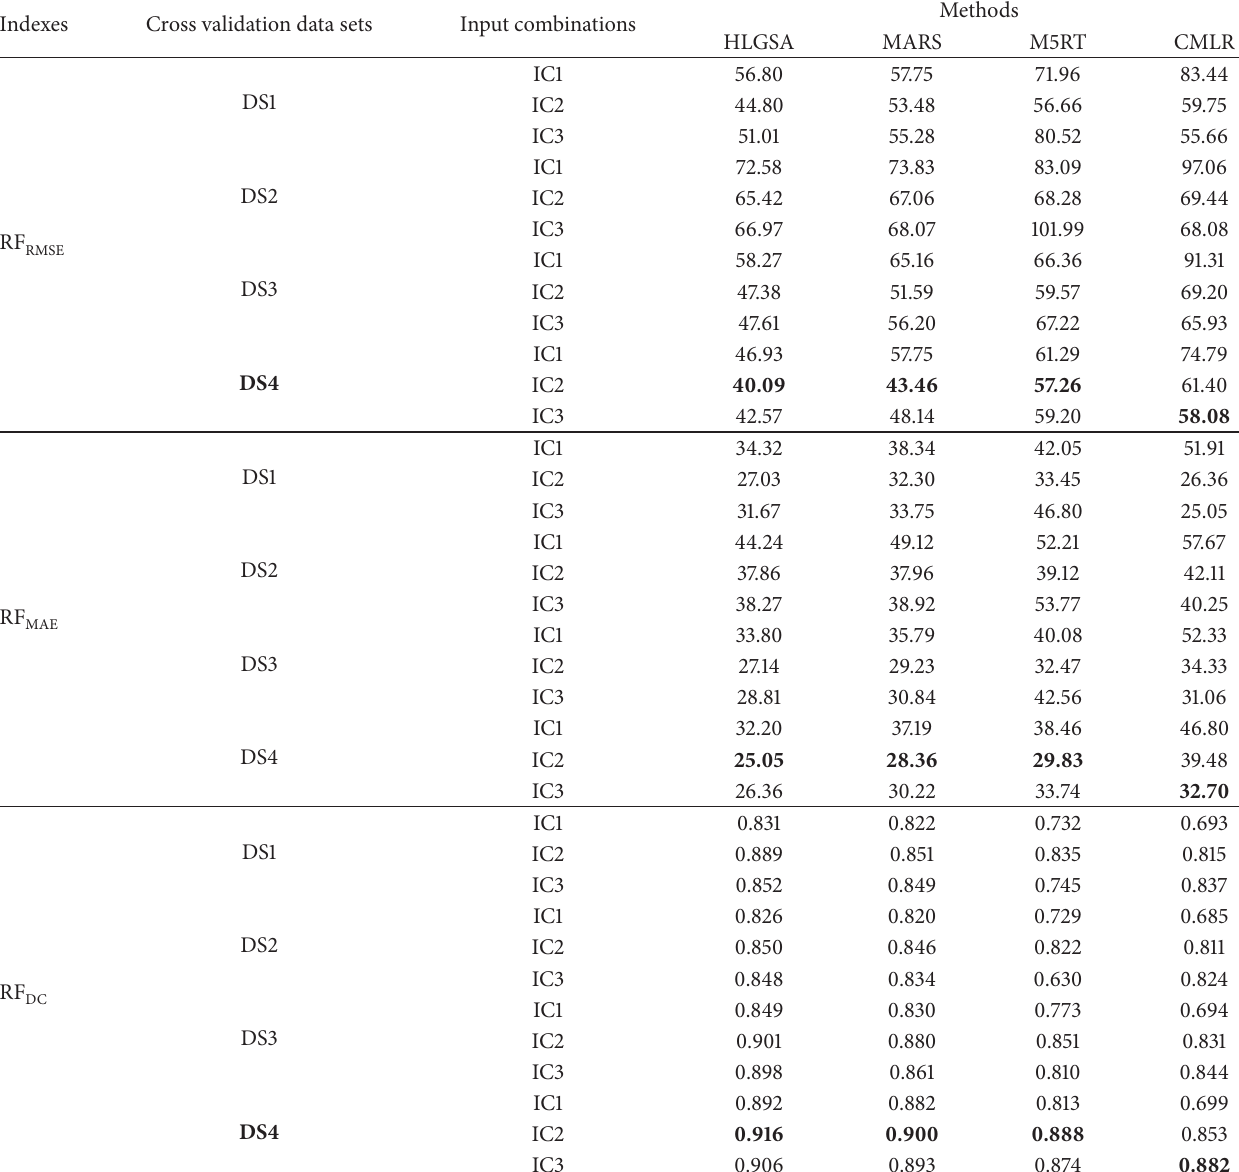
Table 2: Comparison of HLGSA, MARS, M5RT, and CMLR methods: Astore catchment.